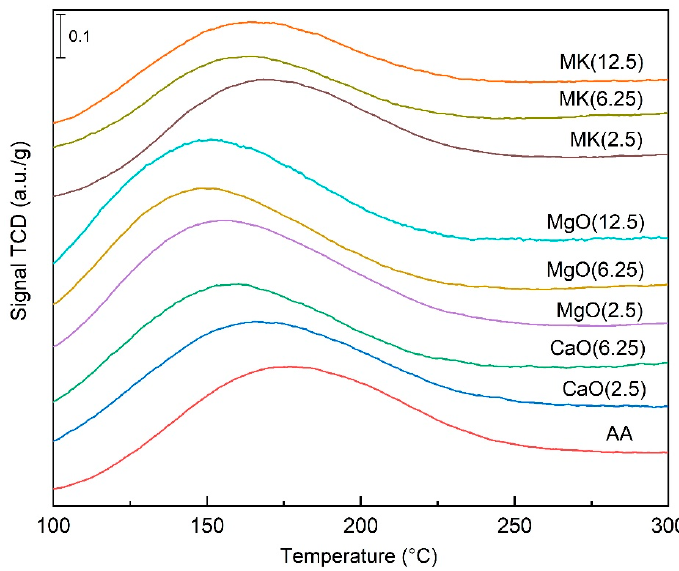
Figure 7. NH 3 -TPD of modified D2 Figure 7. NH 3 ‐ TPD of modified D2 samples. Table 4. Acidity of D2 zeolite foam pellets determined by the NH 3 ‐ TPD Sample